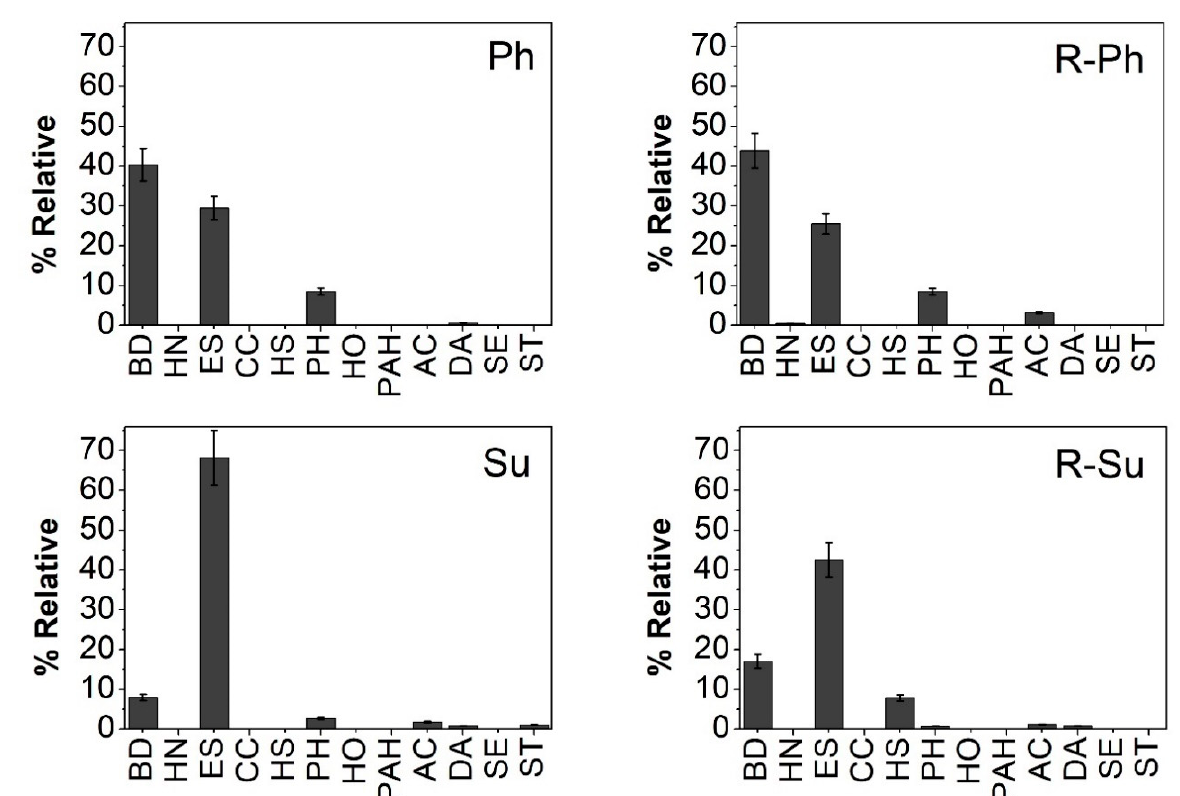
Figure 4. Relative percentage of main classes of compounds identified in hydrochars (Ph, R-Ph, Su, and R-Su). BD = benzene derivative; HN = heterocyclic nitrogen-containing compounds; ES = aliphatic esters; CC = cyclic compounds; HS = heterocyclic sulfur-containing compounds; PH = phenolic compounds; HO = heterocyclic oxygen-containing compounds; PAH = polycyclic aromatic hydrocarbons; AC = alkanes, alkenes, alkynes; DA = dicarboxylic acids; SE = steroids; ST = sterols. The error bars represent standard deviation (SD).